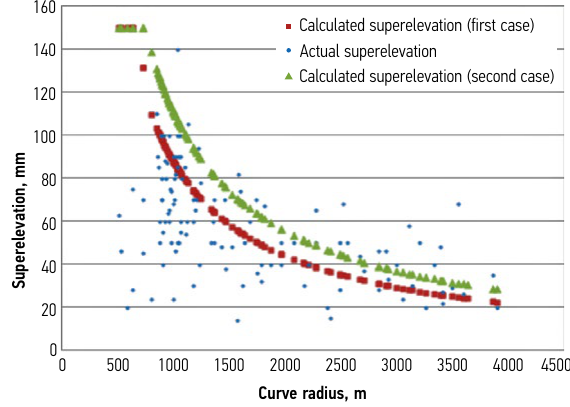
Fig. 4. Actual and calculated superelevation in the curves where permissible train speed is 120/90